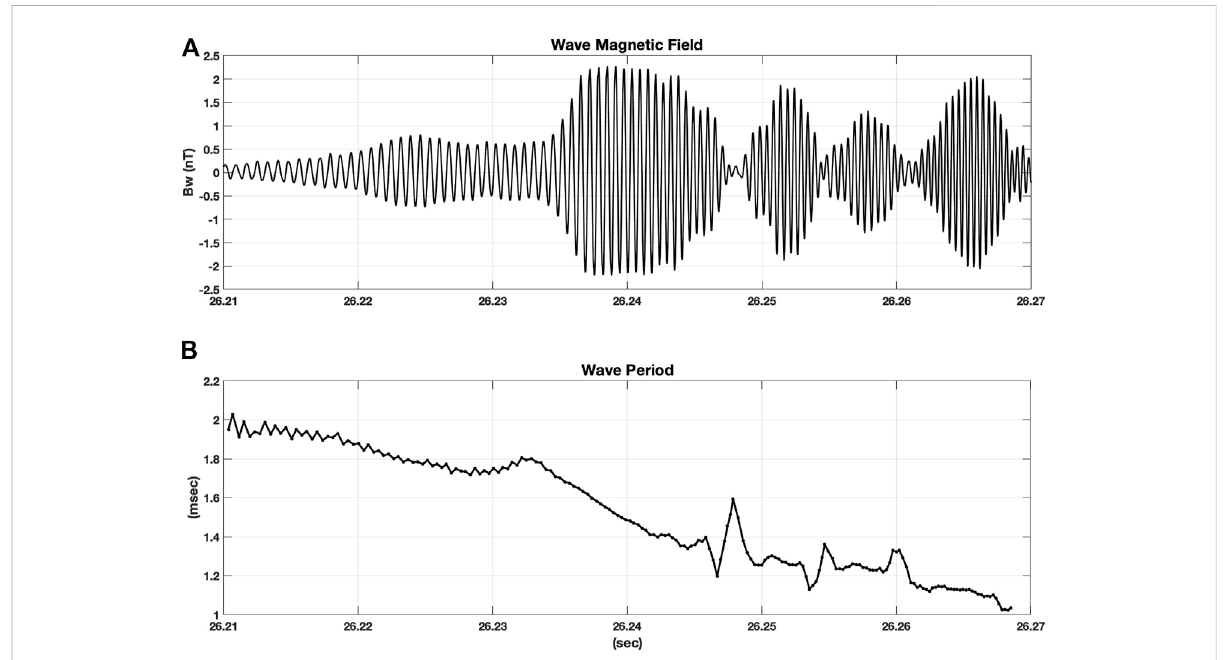
FIGURE 5 (A) Wavemagnetic fi eld(Bw)forthechoruselementshowninFigure4exhibitsasmoothtransitionbetweenthe fi rstandsecondsubpacketsat~ 26.233 s |Bw| exceeds 2.2 nT during the strong second subpacket. (B) A smooth phase transition occurred between the fi rst and second subpackets withsharpdiscontinuities acrosshigherordersubpackettransitions. Waveperiodisdeterminedacross2.5wavecyclesat1/2wavecycleintervalsfor Bw shown in panel (A)